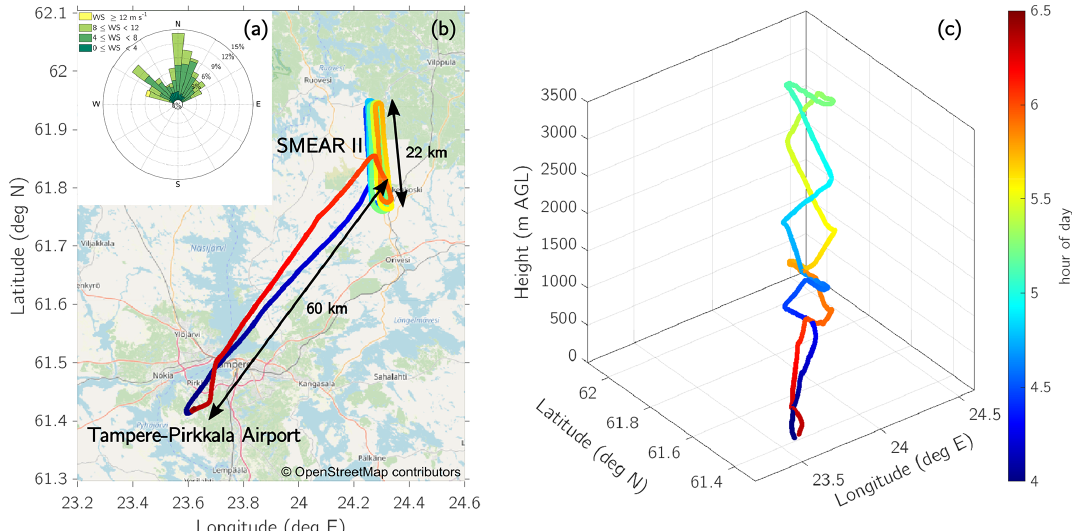
Figure 2. (a) Wind rose of the measured wind direction and wind speed from SMEAR II station at 125m height, including the data from all 6d when airborne measurements were conducted. (b) Flight route from the Tampere–Pirkkala Airport (Finland) to SMEAR II station. The depicted route is from a measurement flight on 2 May 2017 during early morning (04:00–06:30EET). The distance from the airport to SMEAR II station is ∼ 60km, the length of one long leg at the SMEAR II station is ∼ 22km. (c) Profile of the same flight as depicted in (b) but including the height. The colouring of the trajectories represents the hour of the day. © OpenStreetMap contributors 2021. Distributed under the Open Data Commons Open Database License (ODbL)